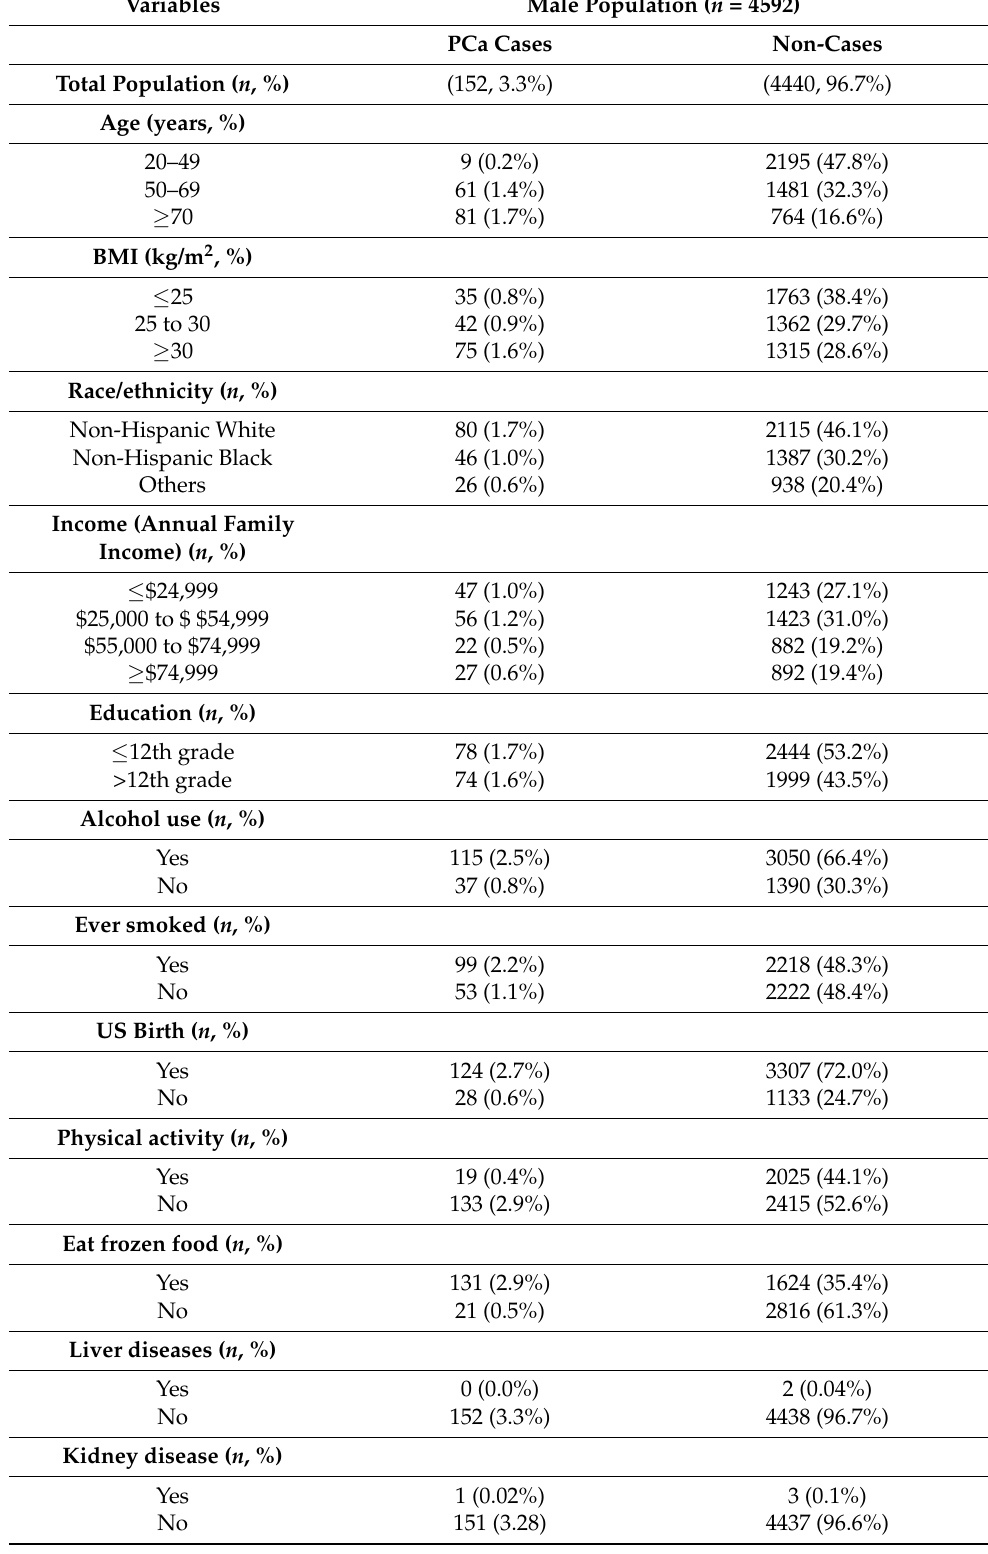
Table 1. Descriptive statistics (categorical variables) for PCa status and selected covariates among men ≥ 20 years of age; NHANES